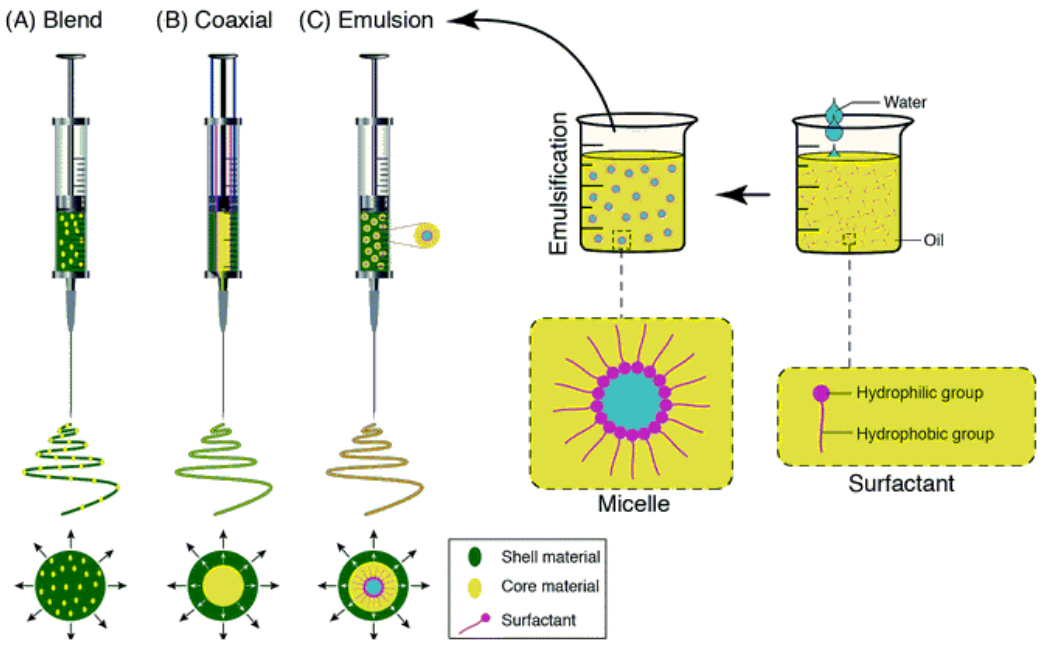
Figure 3. Electrospinning techniques — Blend, Co-axial and emulsion electrospinning. Reproduced from reference [150]with permission from Royal Society of Chemistry.